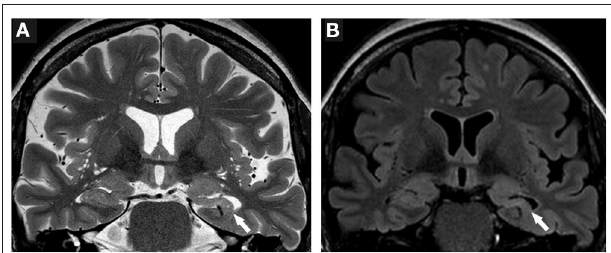
FIGURE 1 | Neuroimaging findings in Patient #4. (A) T2-weighted brain MRI scans reveal hippocampal volume loss and a markedly disturbed inner structure of the hippocampus on the left side (white arrow). (B) FLAIR images further highlight volume loss and signal hyperintensity of the left hippocampus (white arrow). Structures of the right medial temporal lobe do not show pathologic signal alterations.